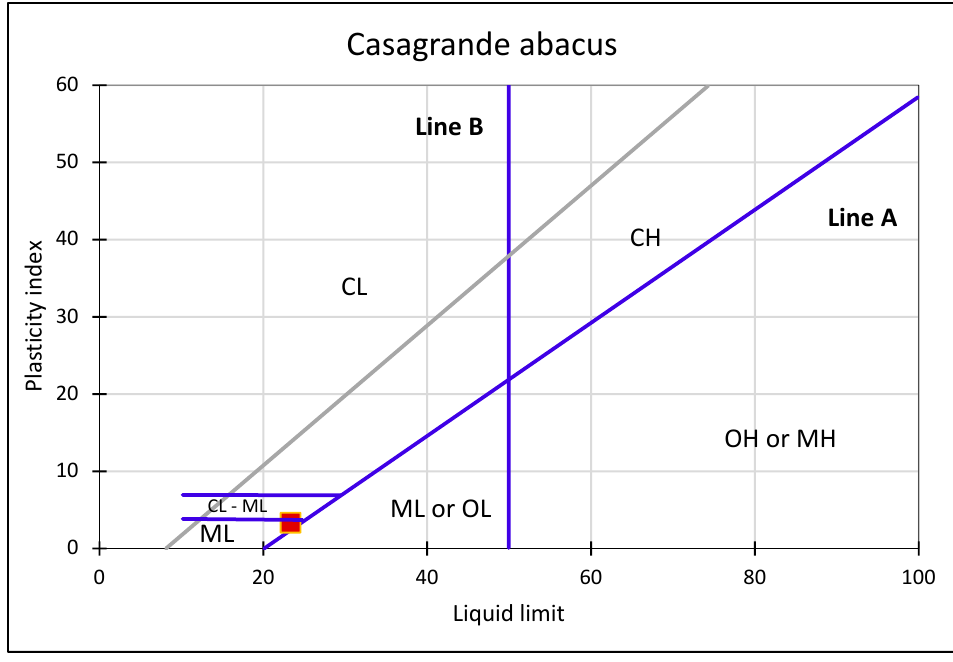
Figure 4. Tailings plasticity